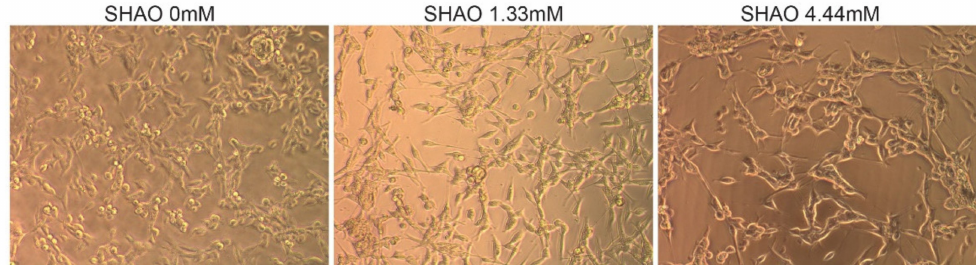
Figure 2. In vitro incubation showing cell morphology in the presence or absence of the SHAO molecule. Images showing 24 h of incubation in vitro of Colon-26 cells with SHAO: 0, 1.32 and 4.44